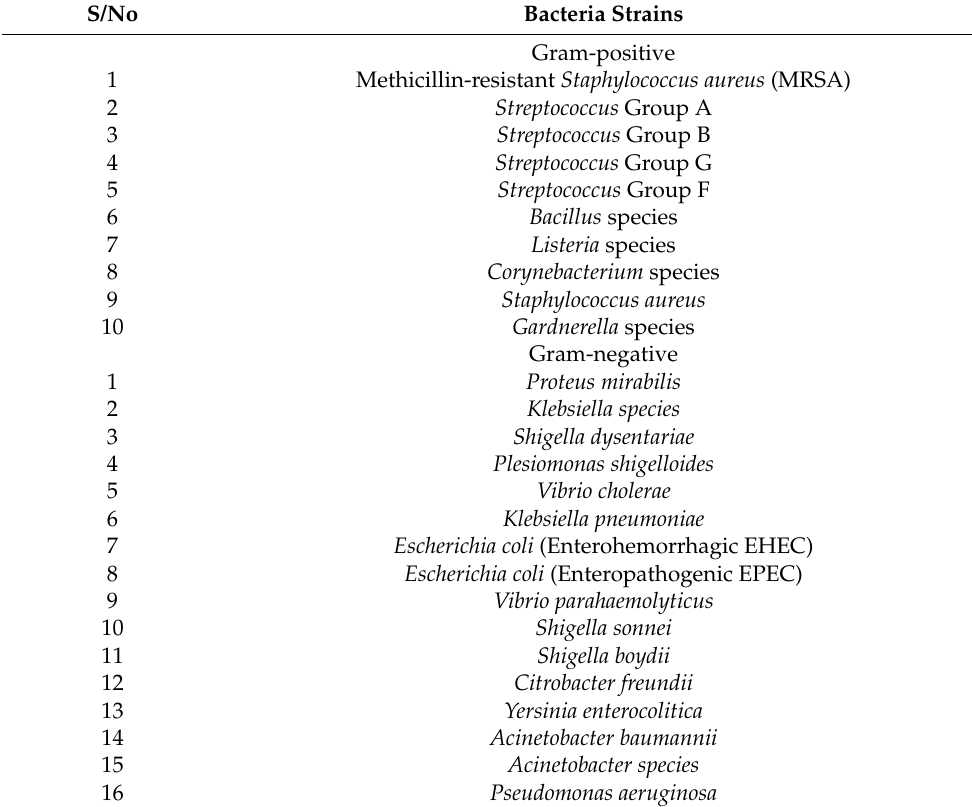
Table 2. Clinical isolates utilized for evaluation of multiplex and monoplex PCR